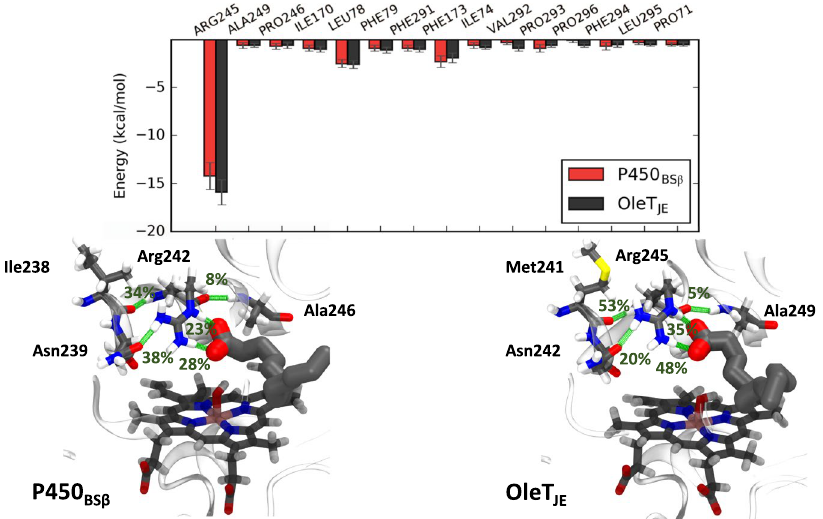
Figure 6. (Top) Substrate binding energy contributions from active site residues. Note that the residue numbers are indicated for OleT JE . (Bottom: Left and Right) Hydrogen bond occupancies for active site arginine in P450 BS β (Center) and OleT JE (Right).